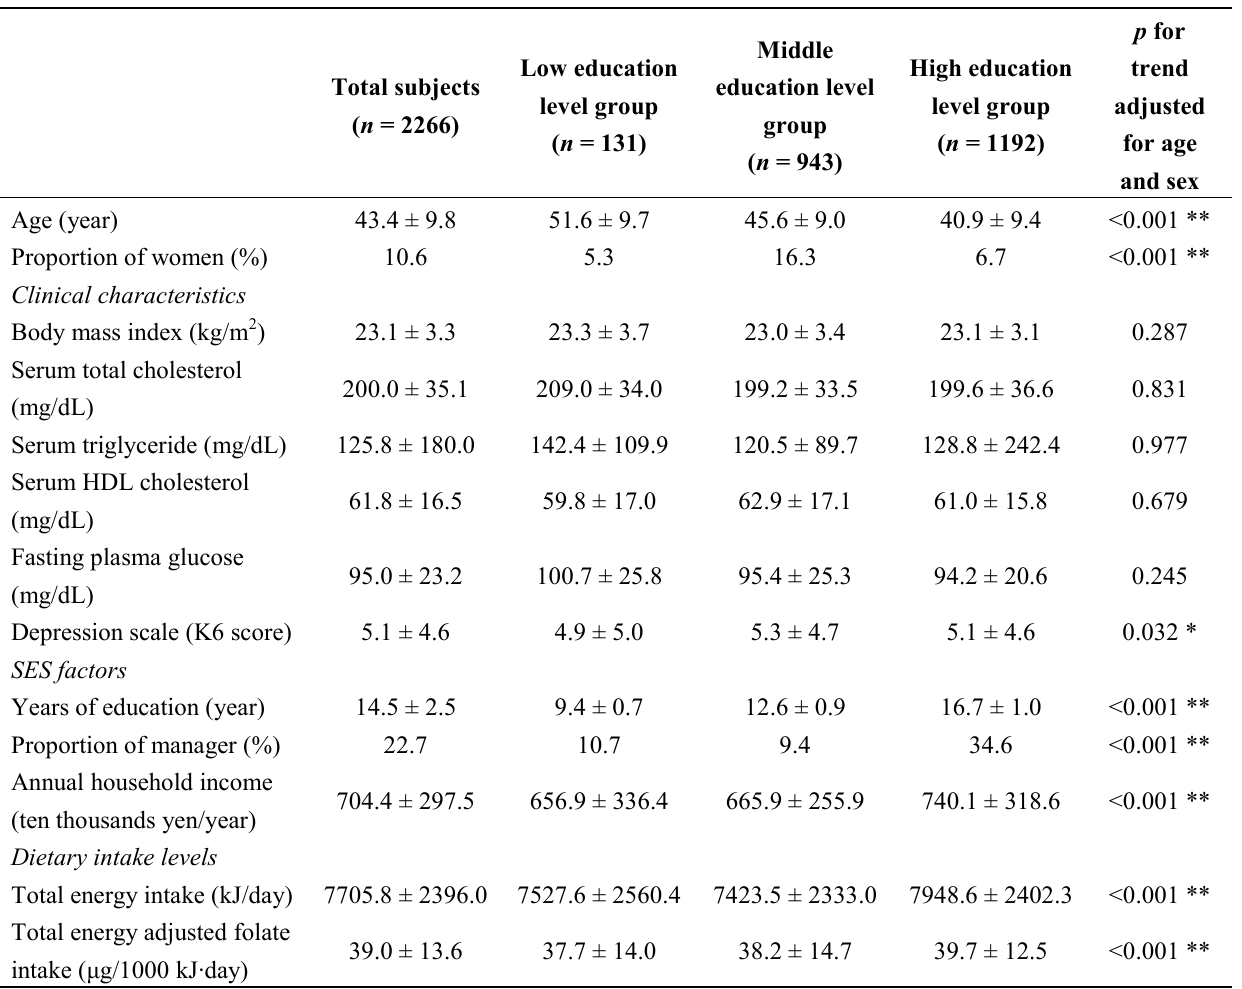
Table 1. Clinical characteristics, dietary nutrients intake data, and socioeconomical status (SES) factors of the study subjects according to different education level